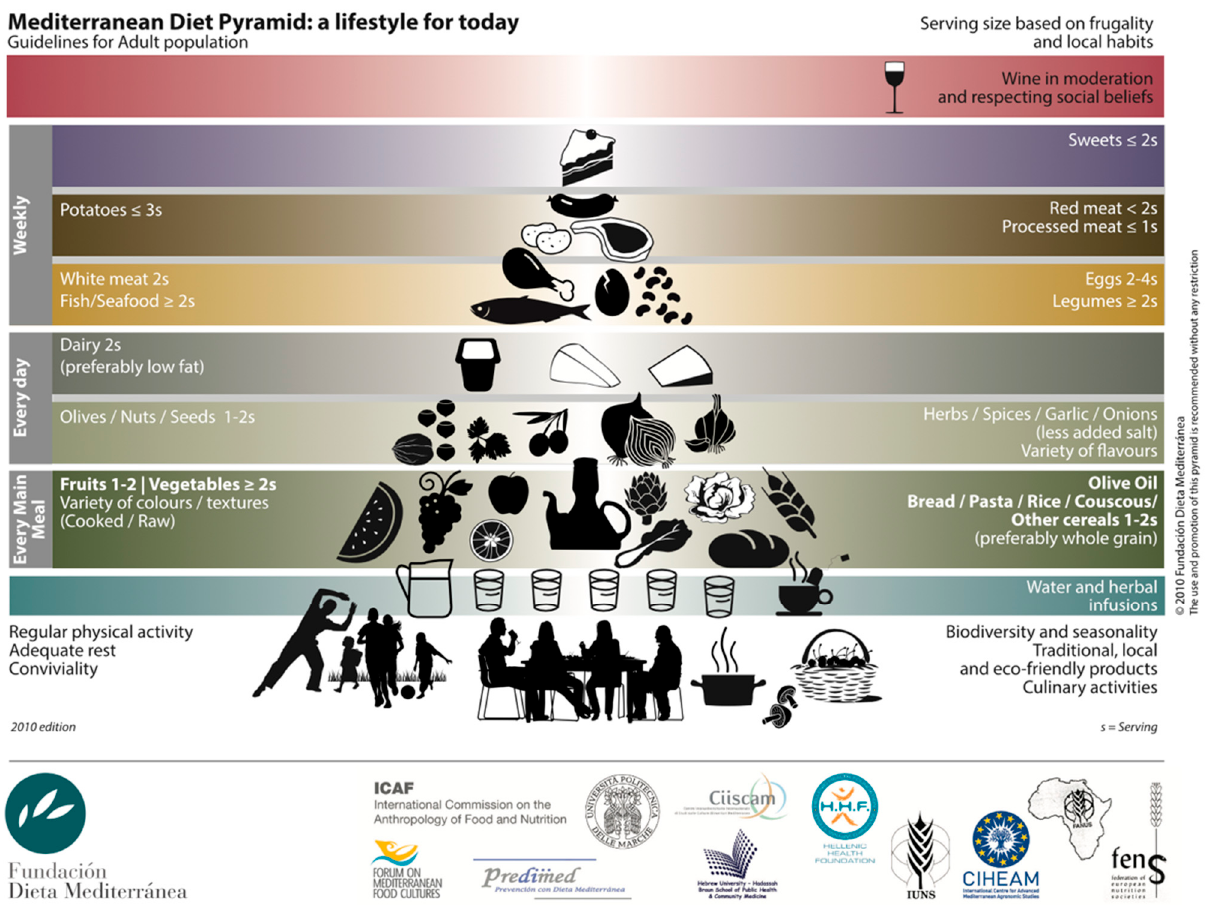
Figure 1. Composition of a Mediterranean Diet. Adapted from [16].